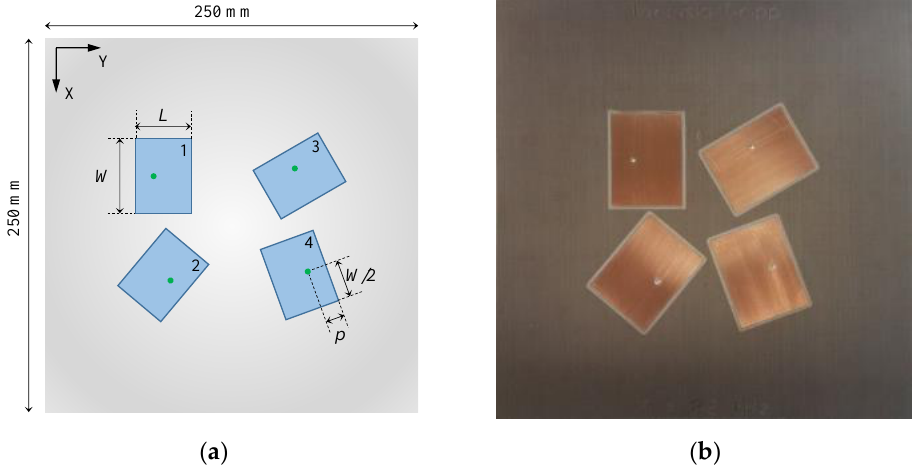
Figure 6. Designed microstrip antenna array: ( a ) Schematic; ( b ) Prototype.